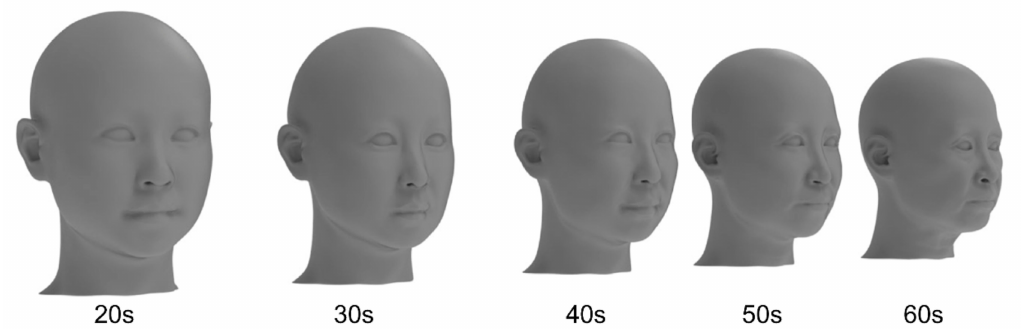
Figure 5. Women’s head 3D data by age